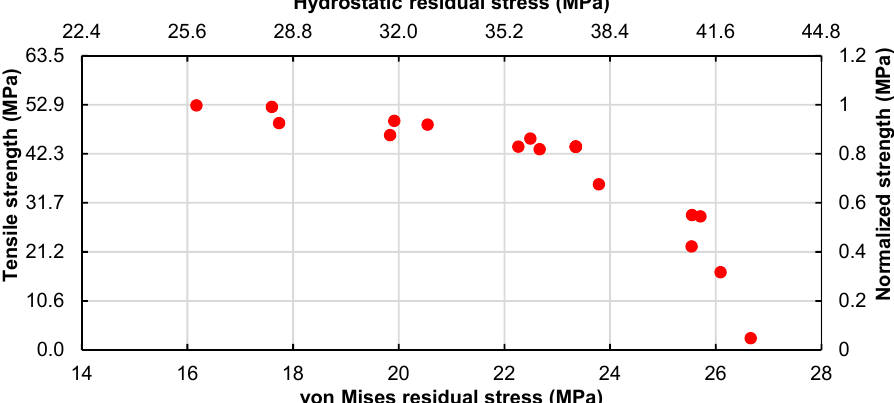
Figure 18. Impact of the average residual stresses on the strength reduction.